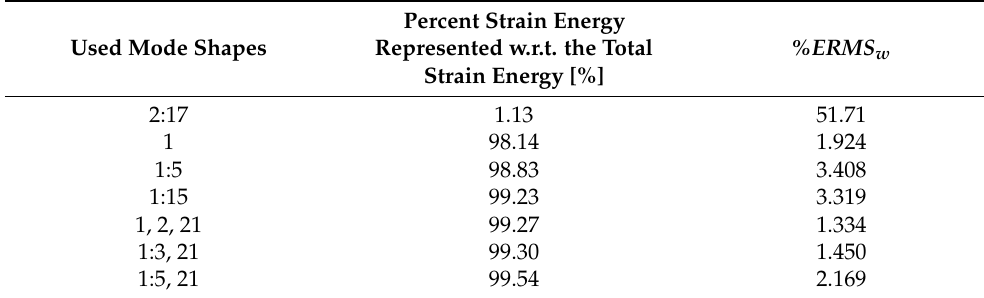
Table 6. % ERMS w errors for different sets of used mode shapes with the Modal Method (1:5 = from mode 1 to 5).